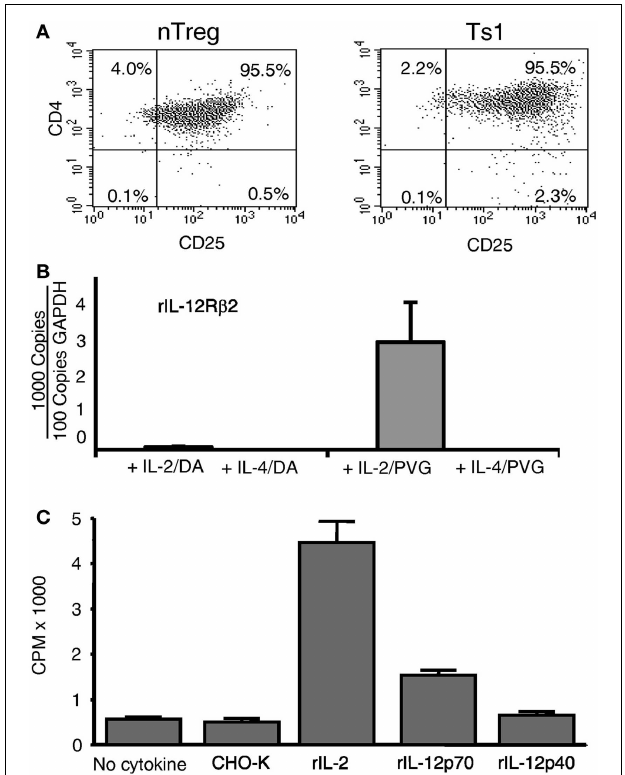
FIGURE 2 | Expression of CD25 and il-12r β 2 and in vitro proliferation in MLC of naïve CD4 + CD25 + T cells . (A) Comparison of naïve CD4 + CD25 + T cells before and after culture with rIL-2 and alloantigen.The majority of CD4 + T cells expressed CD25 before culture (nTreg) and remained CD25 + post-culture with rIL-2 and alloantigen (Ts1). Replicated in several experiments. (B) Expression of il-12r β 2 in CD4 + CD25 + T cells (nTreg) from DA rats cultured for 3days with DA (auto) or PVG (allo) stimulators in the presence of rIL-2, rIL-4, or no cytokines.The CD25 + population was re-enriched to remove stimulator cells. il-12r β 2 was increased in CD4 + CD25 + T cells cultured with rIL-2 and alloantigen to induceTs1 cells and to a lesser extent with autoantigen.There was no il-12r β 2 expression in nTreg cultured with alloantigen alone with no cytokine as well as those cultured with rIL-4 and auto- or alloantigen.There was no expression of il-2 , confirming noTh1 induction after culture with rIL-2, ifngr was induced, but not with rIL-4, as described (8) (data not shown). One of three experiments with similar results. (C) Proliferation ofTs1 cells re-cultured with alloantigen and rIL-12p70. nTreg were simulated with PVG stimulators and rIL-2 for 4days to produceTs1 cells that were washed and then re-stimulated for